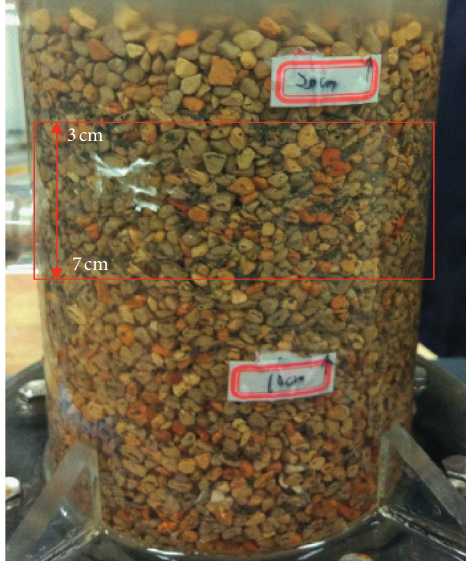
Figure 9: Deposited position of captured particulate